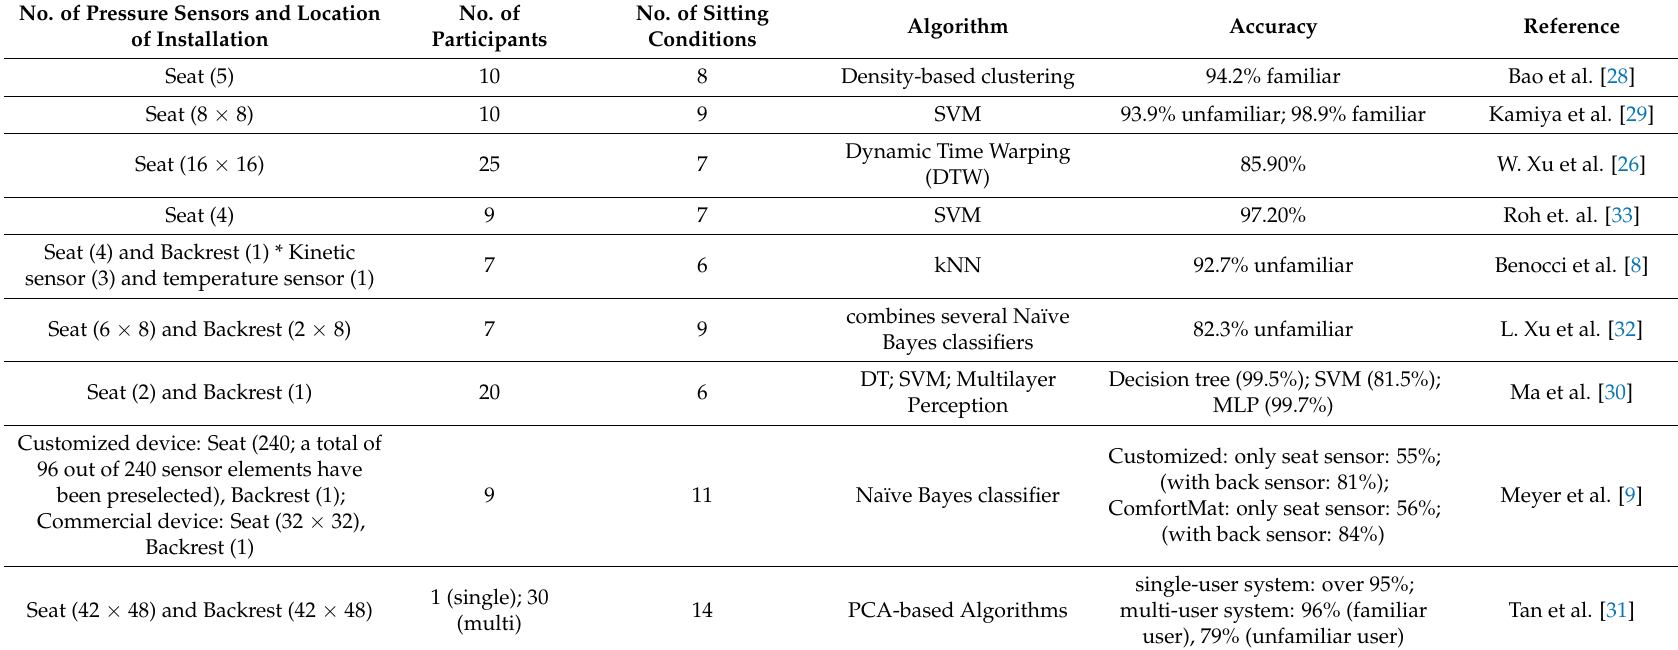
Table 1. Detail information of previous studies on classification of sitting